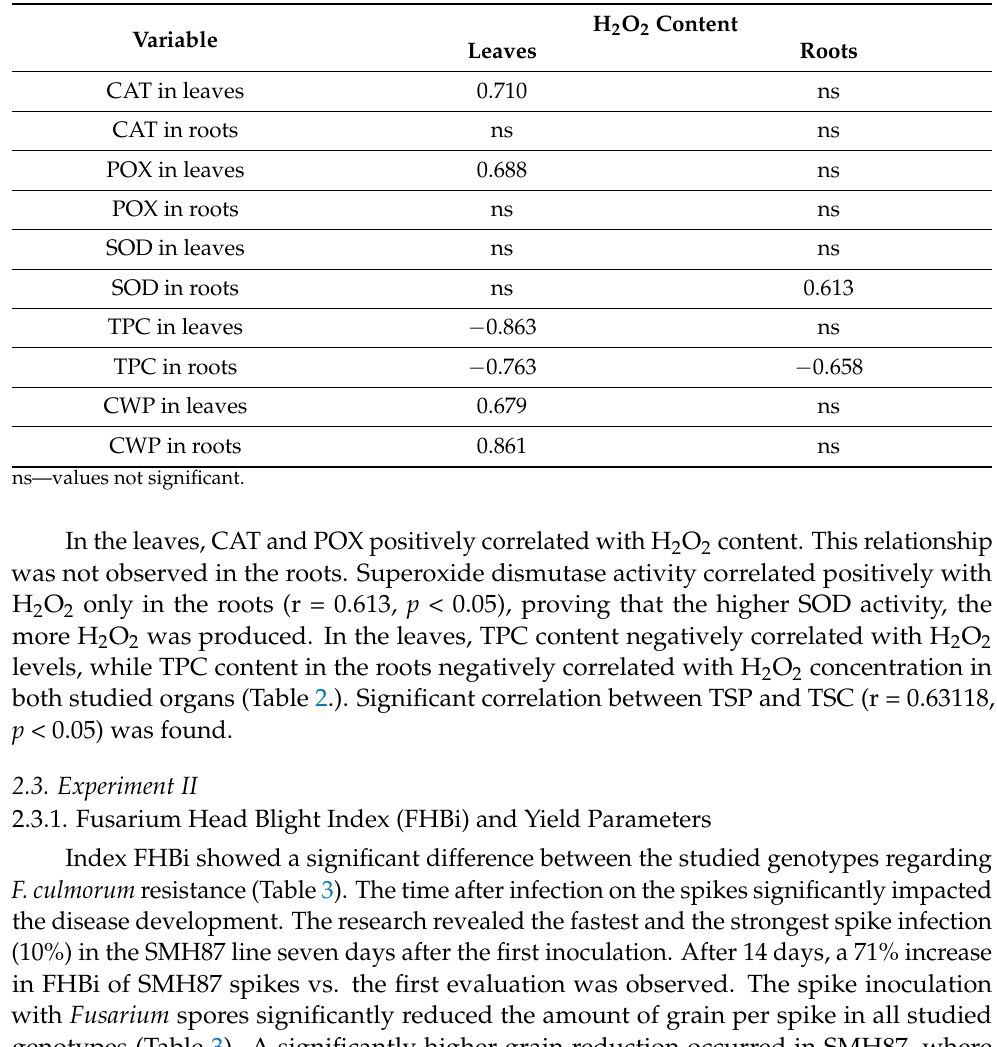
Table 2. Pearson coefficients of linear correlation ( p < 0.05) between H 2 O 2 content in the leaves and roots and the activity of catalase (CAT), peroxidases (POX), superoxide dismutase (SOD), as well as total soluble phenolic (TSP) and cell wall-bound phenolic (CWP) content in the leaves and roots of three accessions of durum